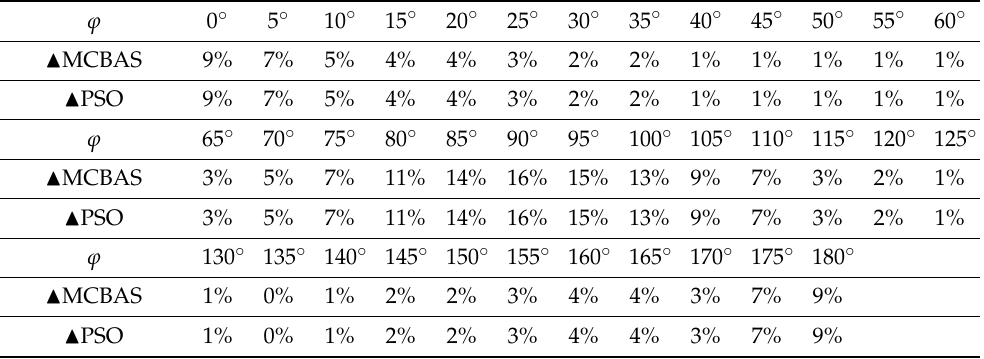
Table 5. The total power conversion improvement rate compared to the baseline with the 3 × 3 matrix OWF.